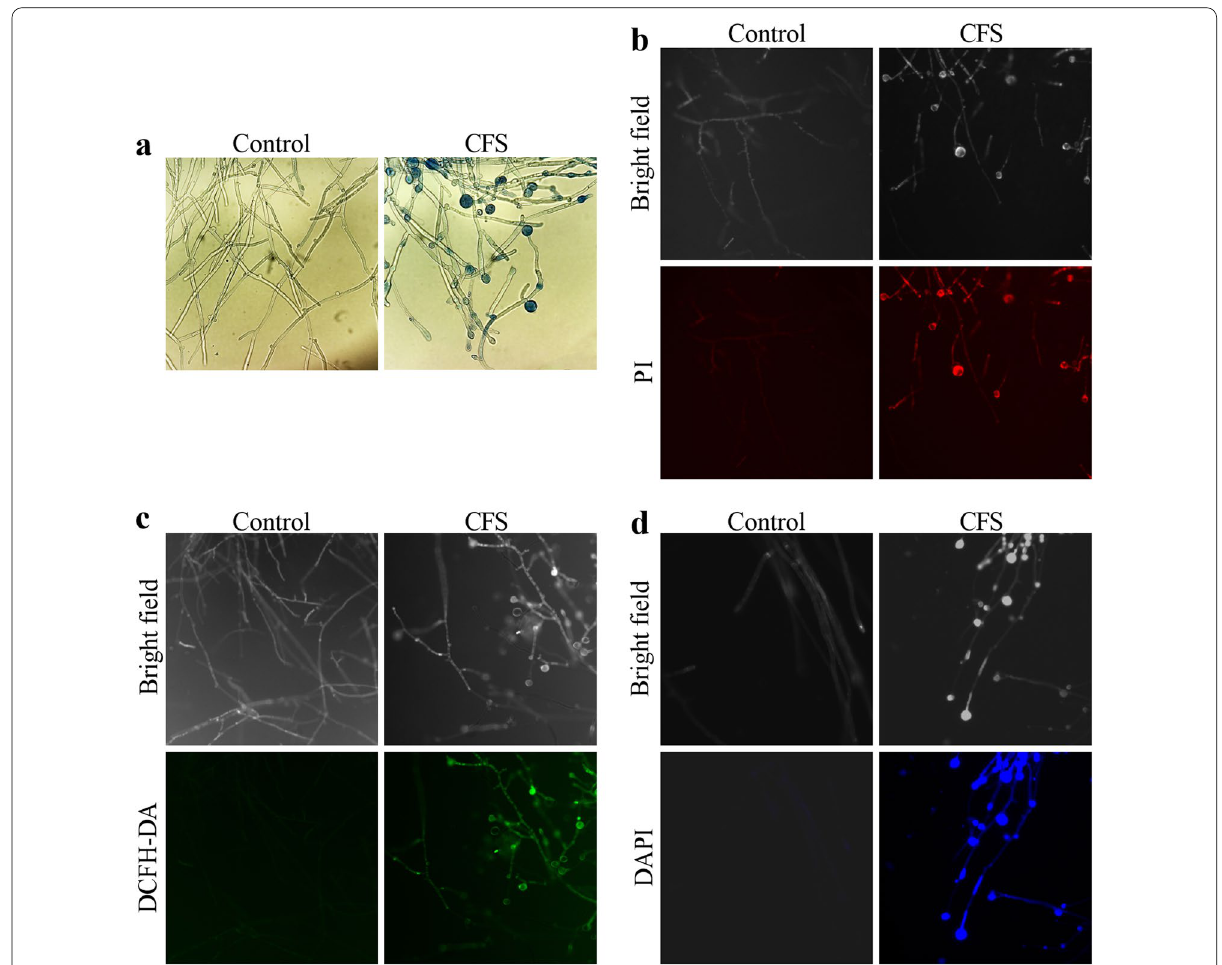
Fig. 5 Effect of compound fermentation supernatants (CFS) on mycelial cell of Rhizoctonia cerealis. a Effect of CFS on mycelial cell death; b Effect of CFS on cell membrane permeability . The fluorescence excitation wavelength is 536 nm; c Effect of CFS on ROS accumulation. The fluorescence excitation wavelength is 448 nm; d Effect of CFS on DNA damage . The fluorescence excitation wavelength is 340